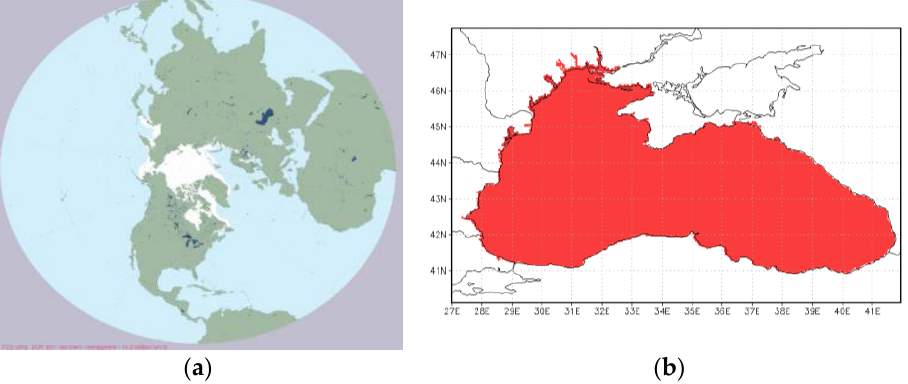
Figure 3. ( a ) MAISIE-NH product projection; the geotiff image was processed to obtain Mercator projection and only the Black Sea area was cut. Then, the pixels indicating area of ice were counted, and thus the sea-ice cover was estimated. ( b ) Mask for the Black Sea pixels.